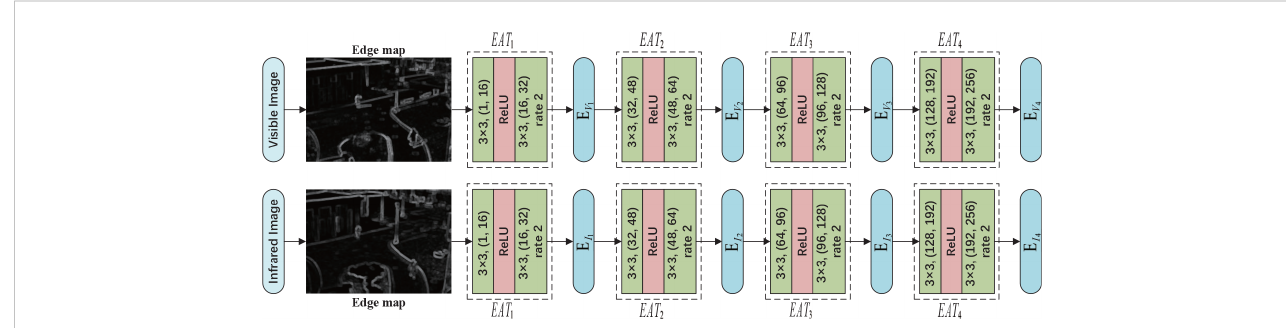
FIGURE 7 The architecture of edge attention module. The EAT 1-4 are designed to generate shallow to deep edge feature maps E V the ‘ k × k ,( in , out ) ‘ means that the convolution kernel size is k × k , the input channel is in and output channel is out . In addition, the ‘ rate 2 ’ denotes the dilated convolution operator with a dilation rate of